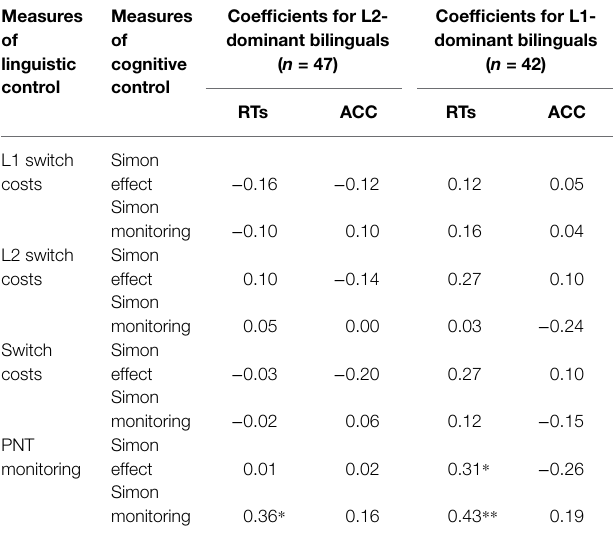
TABLE 9 | Pearson correlations between measures of linguistic control in the picture naming task (shortened as PNT) and of cognitive control measured by the Simon task in terms of response times (RTs) and accuracy rates (ACC), respectively, conducted for L1- and L2-dominant bilinguals with controlling for